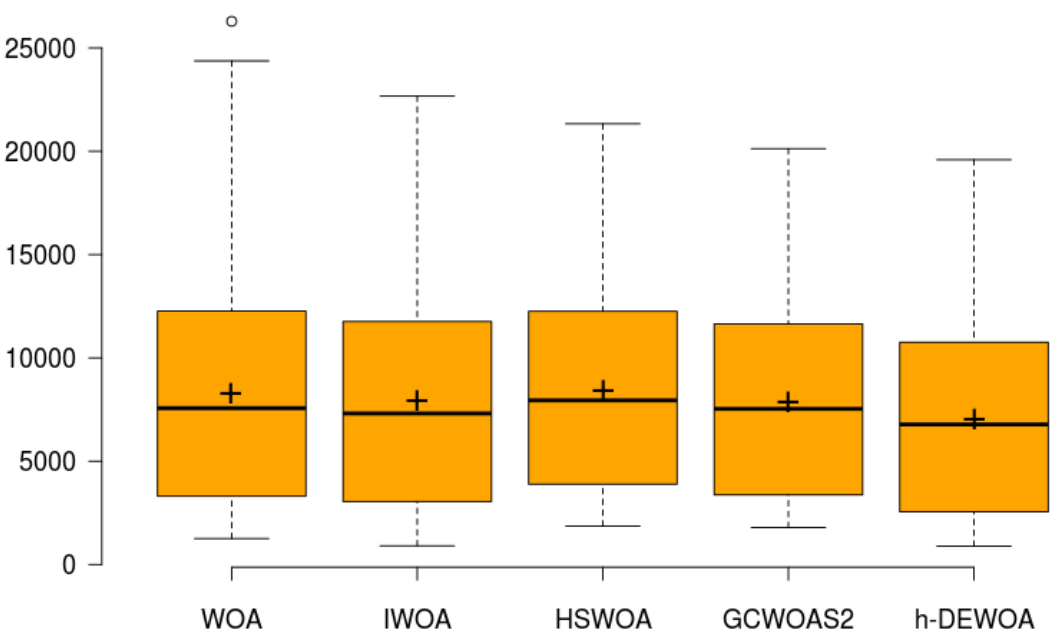
Figure 14. Comparative boxplot analysis of the overall energy consumption of h-DEWOA- and WOA-based scheduling algorithms for HPC2N workloads.